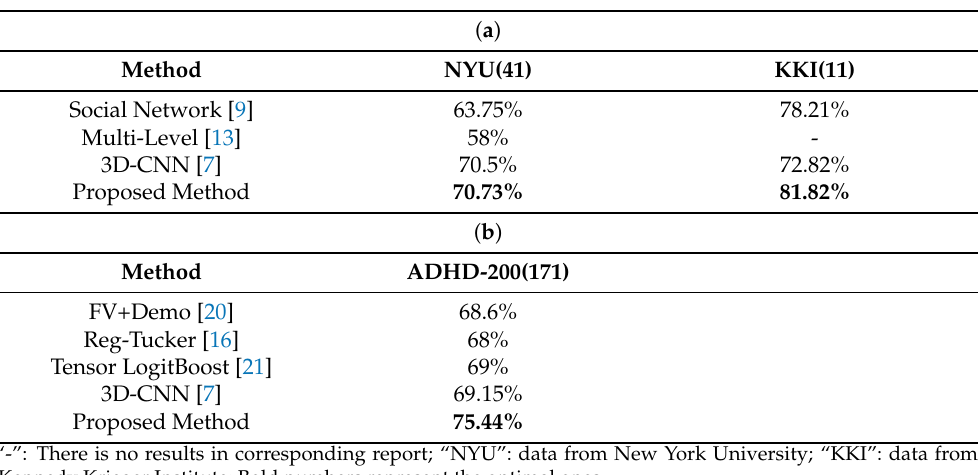
Table 2. The Comparison of Classification Accuracy (a) on sub-datasets NY and KKI and (b) on whole ADHD-200 dataset.